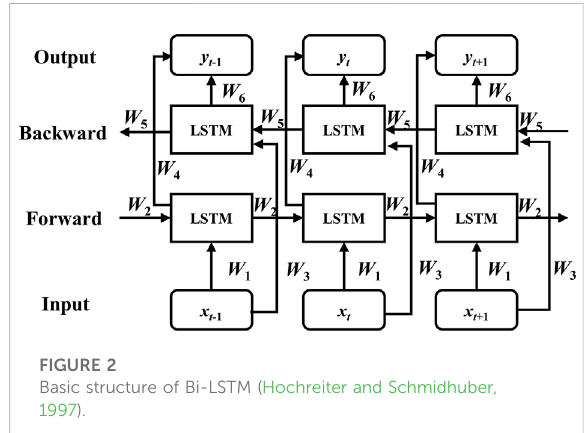
FIGURE 2 Basic structure of Bi-LSTM (Hochreiter and Schmidhuber,